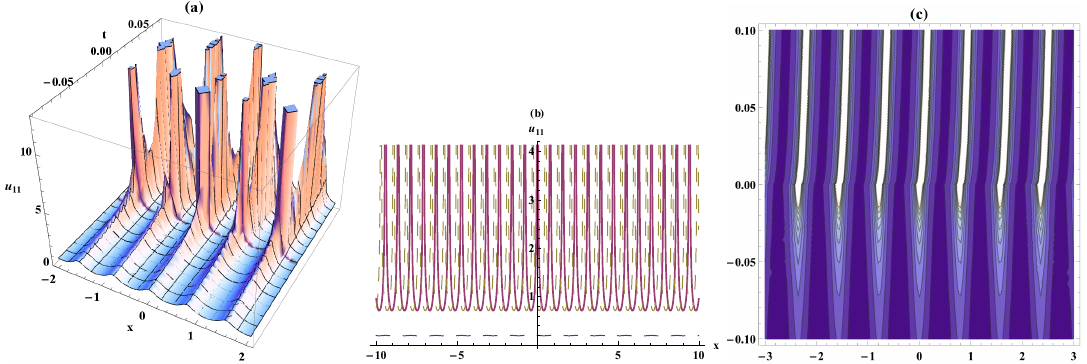
Figure 4. Periodic solitary wave, the bistable wave amplitude and contour plots for Equation (21). On the respectively interval { x , − 2.05,2.05 } , { t , − 0.08,0.08 } , { x , − 10,10 } , { t , − 1,1 } , { x , − 3,3 } , { t , − 0.1,0.1 }